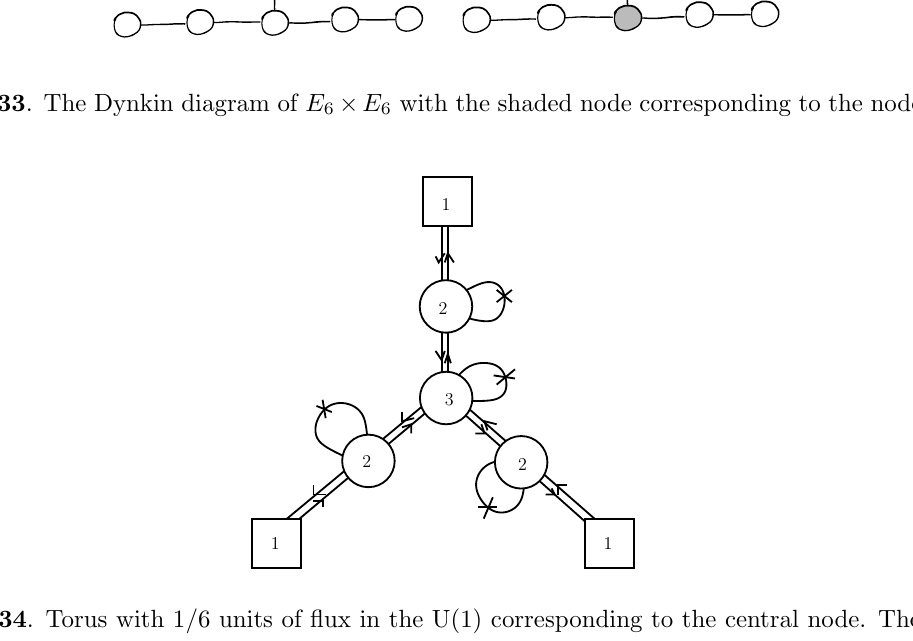
Figure 34 . Torus with 1 = 6 units of (cid:13)ux in the U(1) corresponding to the central node. The lines from vertex to itself are adjoint plus a